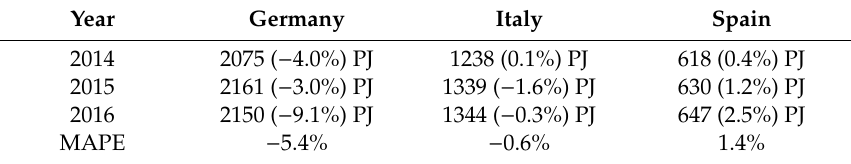
Table 3. Validation of Equation (2). The error with respect to the real data is presented in parentheses.